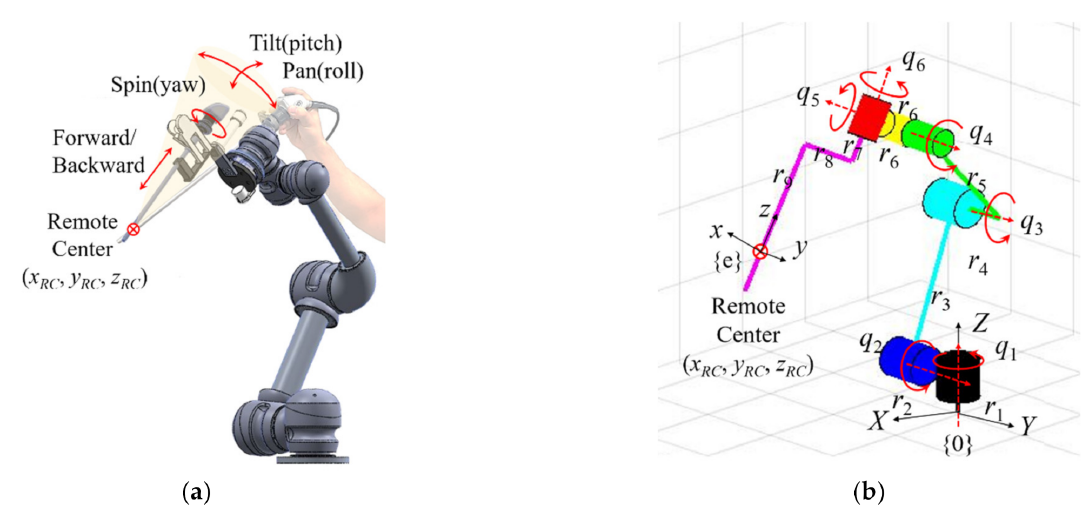
Figure 2. Kinematic model of the surgical assistant robot: ( a ) remote center motion; ( b ) configuration of joints and